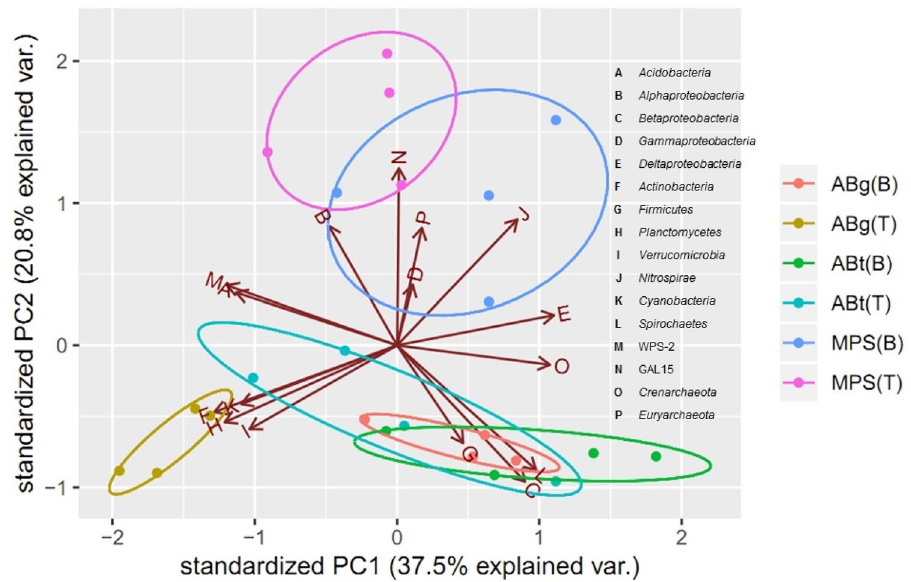
Figure 4. Principal component analysis (PCA) of forest types and the major prokaryotic taxa in Maludam National Park. Scatter plot shows principle component 1 (PC1) versus principle component 2 (PC2). Percentages shown are percentages of variation explained by